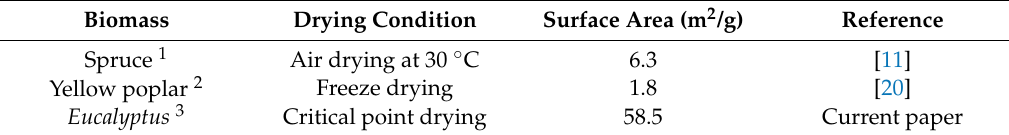
Table 2. Drying method effect on the Brunauer–Emmett–Teller (BET) surface area.